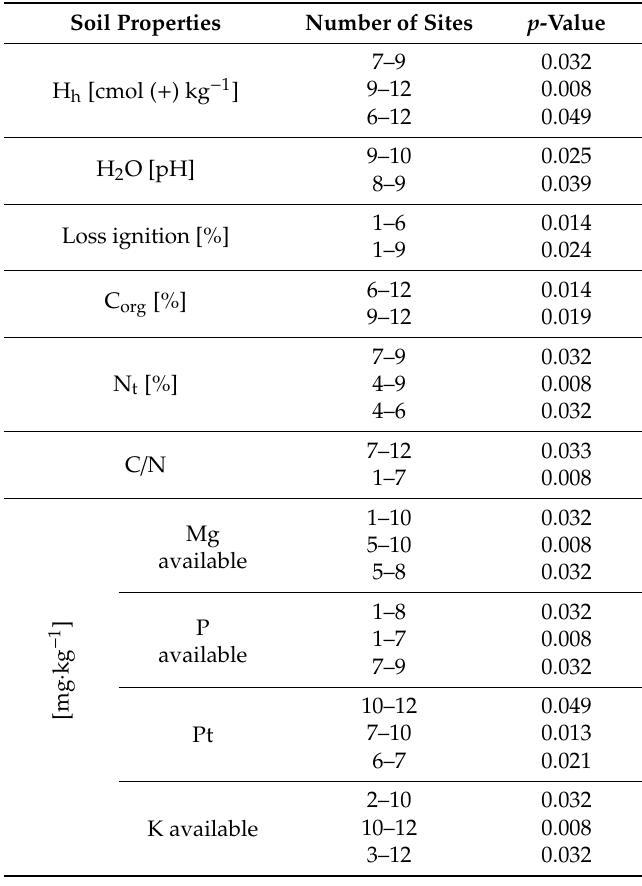
Table 4. Pairwise comparisons between sites (statistically significant di ff erence in the Kruskal–Wallis test: α =